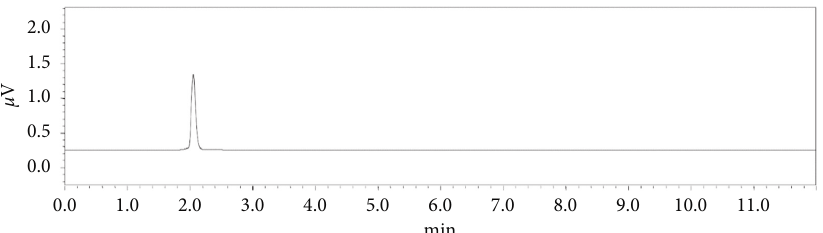
Figure 6: Typical chromatogram for the degraded levamisole standard with 30% H